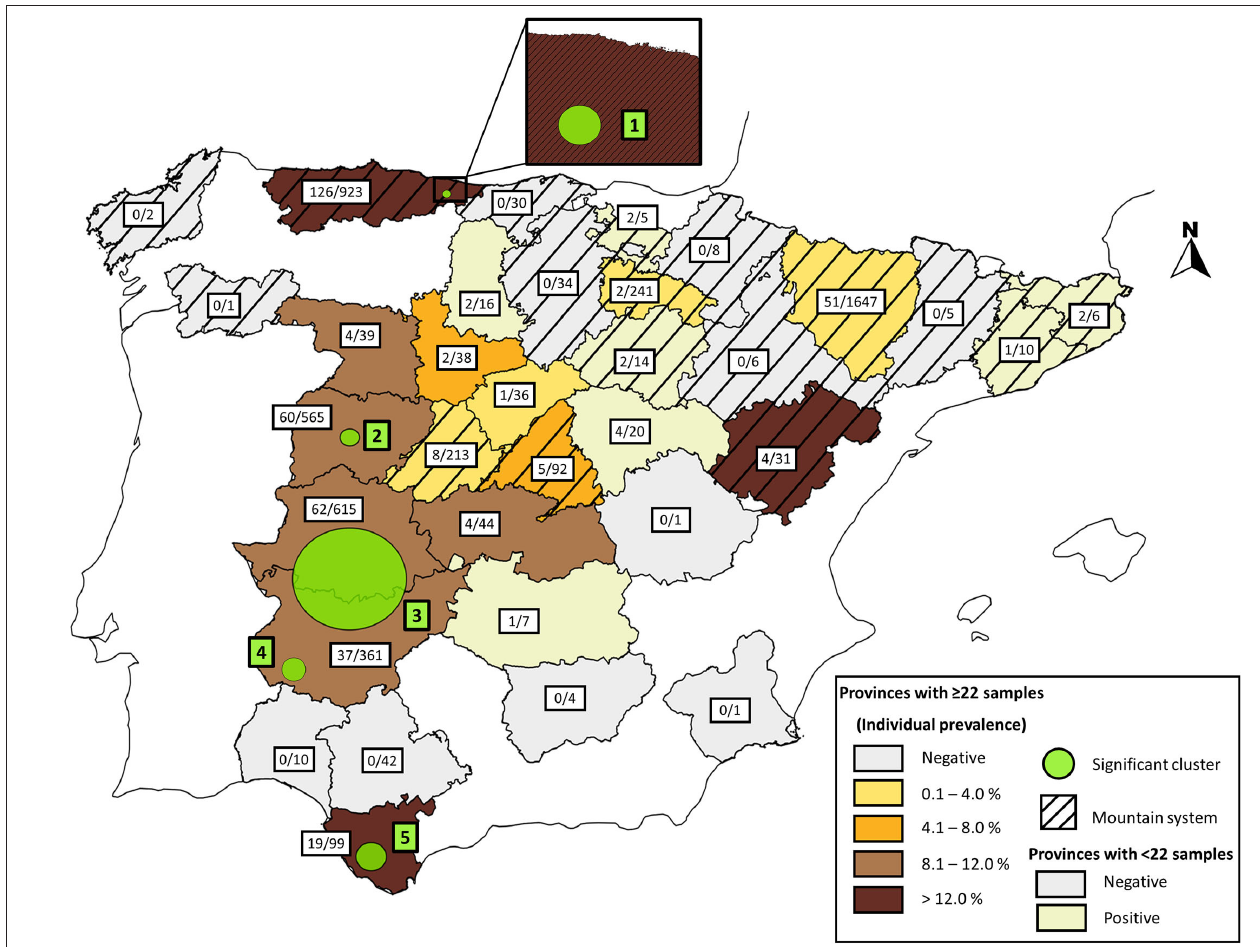
FIGURE 2 | Map of Spain overlaying the areas with a potential risk of BGC represented with a circle and the apparent prevalence of Cfv in bulls between 2011 and 2019, colored according to their percentage value. The striped and unlined patterns indicate mountain and “dehesa” areas, respectively.